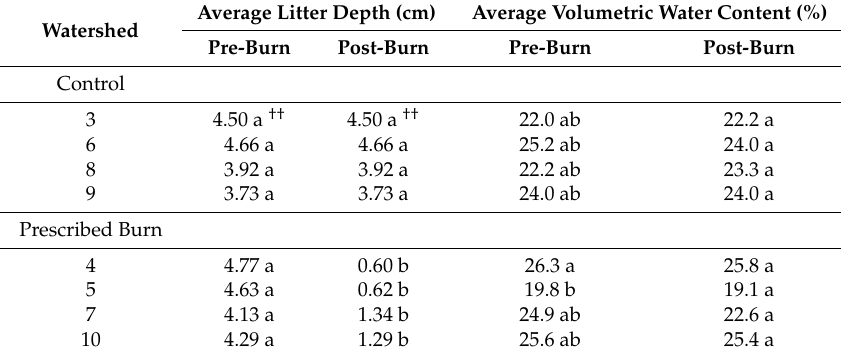
Table 4. Average pre- and post-burn litter depth and soil moisture for experimental watersheds at Trail of Tears State Forest,